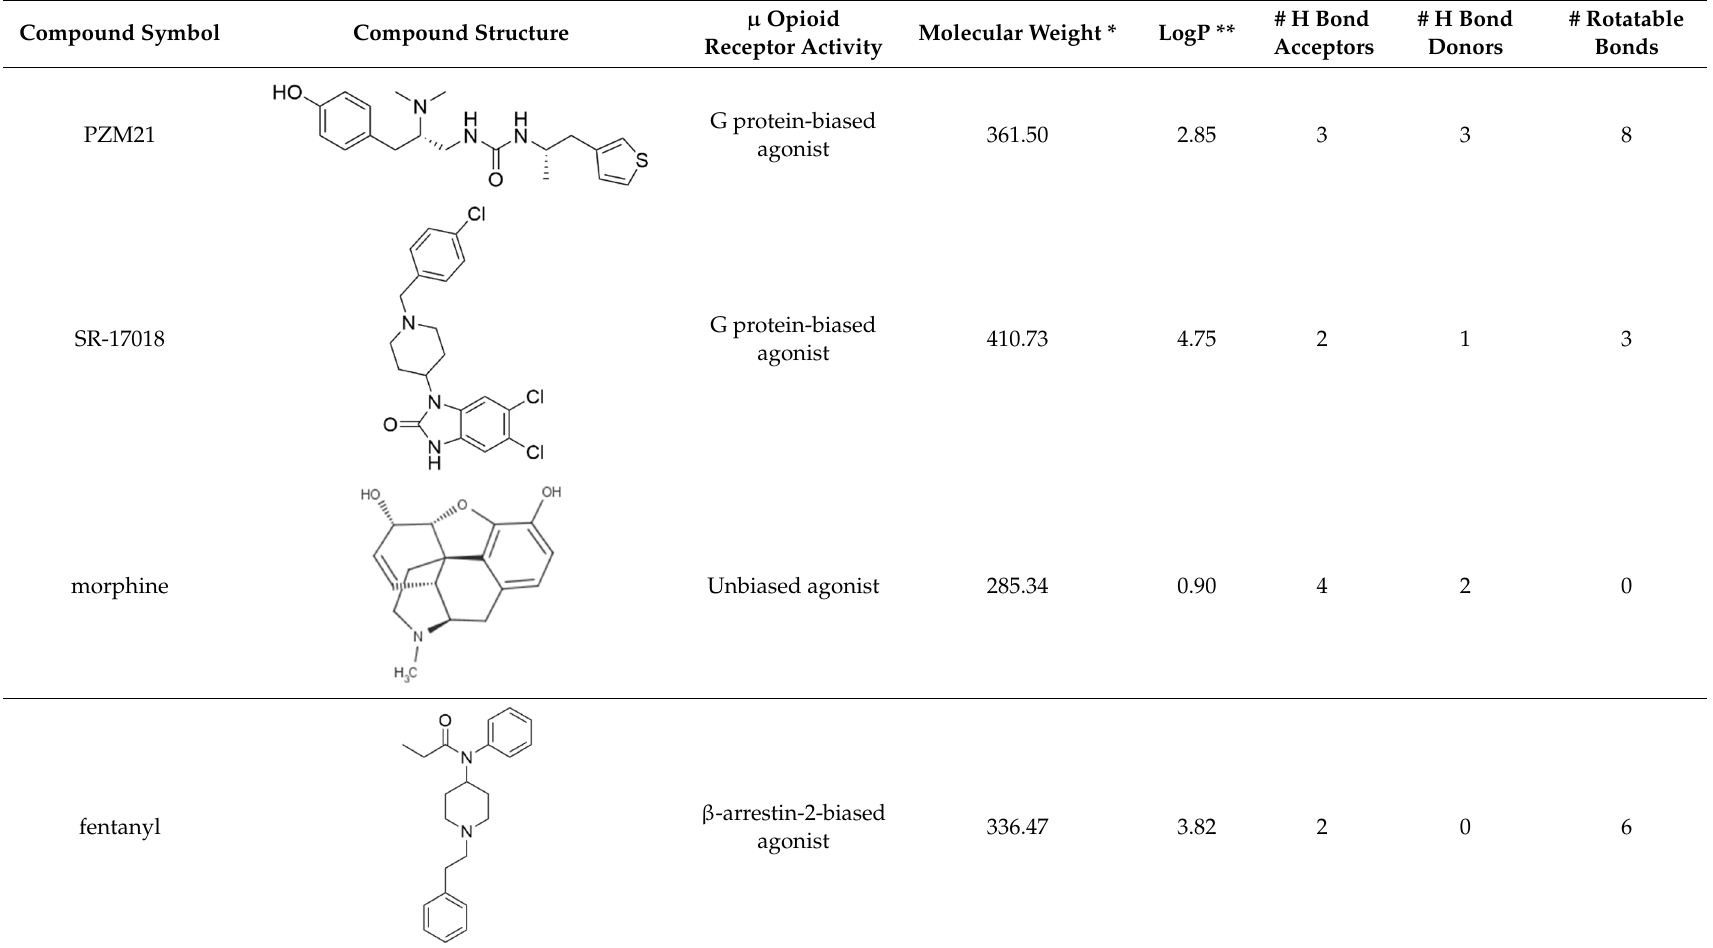
Table 1. Structure and properties of the µ opioid receptor ligands examined in the study.